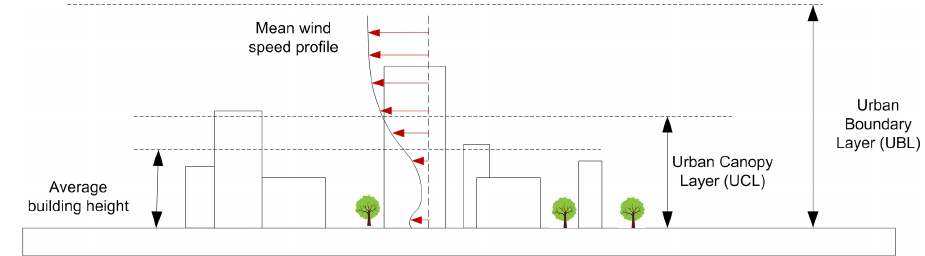
Figure 1. The urban wind profile, mainly composed of the Urban Boundary Layer (UBL) and the Urban Canopy Layer (UCL). Figure adapted from Ng et al. [6].